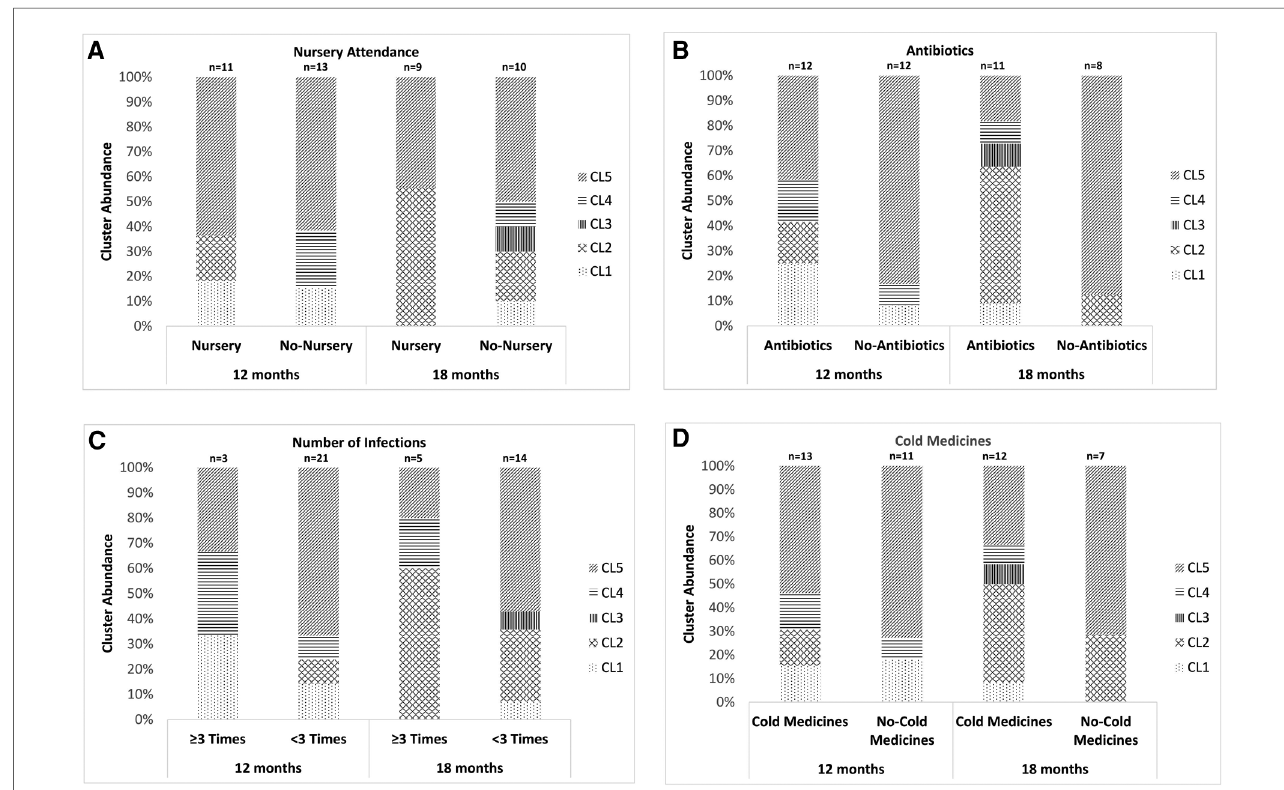
FIGURE 4 The association between the results of the clustering analysis using the URT secretions from children aged around 12 or 18 months old and environmental factors. ( A ) Nursery attendance, ( B ) use of antibiotics after the latest sampling, ( C ) history of ≥ 3 URTI episodes after the fi rst sampling and ( D ) use of cold medicines between the previous and present samplings. The 5 clusters indicate Mixed (CL1), Haemophilus aegyptius/in fl uenzae- dominated (CL2), Staphylococcus aureus- dominated (CL3), Corynebacterium propinquum -dominated (CL4) and Moraxella catarrhalis/nonliquefaciens -dominated (CL5). URTI: upper respiratory tract infection, URT: upper respiratory tract, CL: